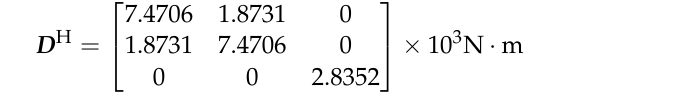
Figure 10. Third-order influence function 𝝌 3 of the CCCC single-layer periodic plate. (𝐚) 𝑚𝑛𝑝 = 111 ; (𝐛) 𝑚𝑛𝑝 = 221 ; (𝐜) 𝑚𝑛𝑝 = 121 ; (𝐝) 𝑚𝑛𝑝 = 112 ; (𝐞) 𝑚𝑛𝑝 = 222 ; (𝐟) 𝑚𝑛𝑝 = 122 .